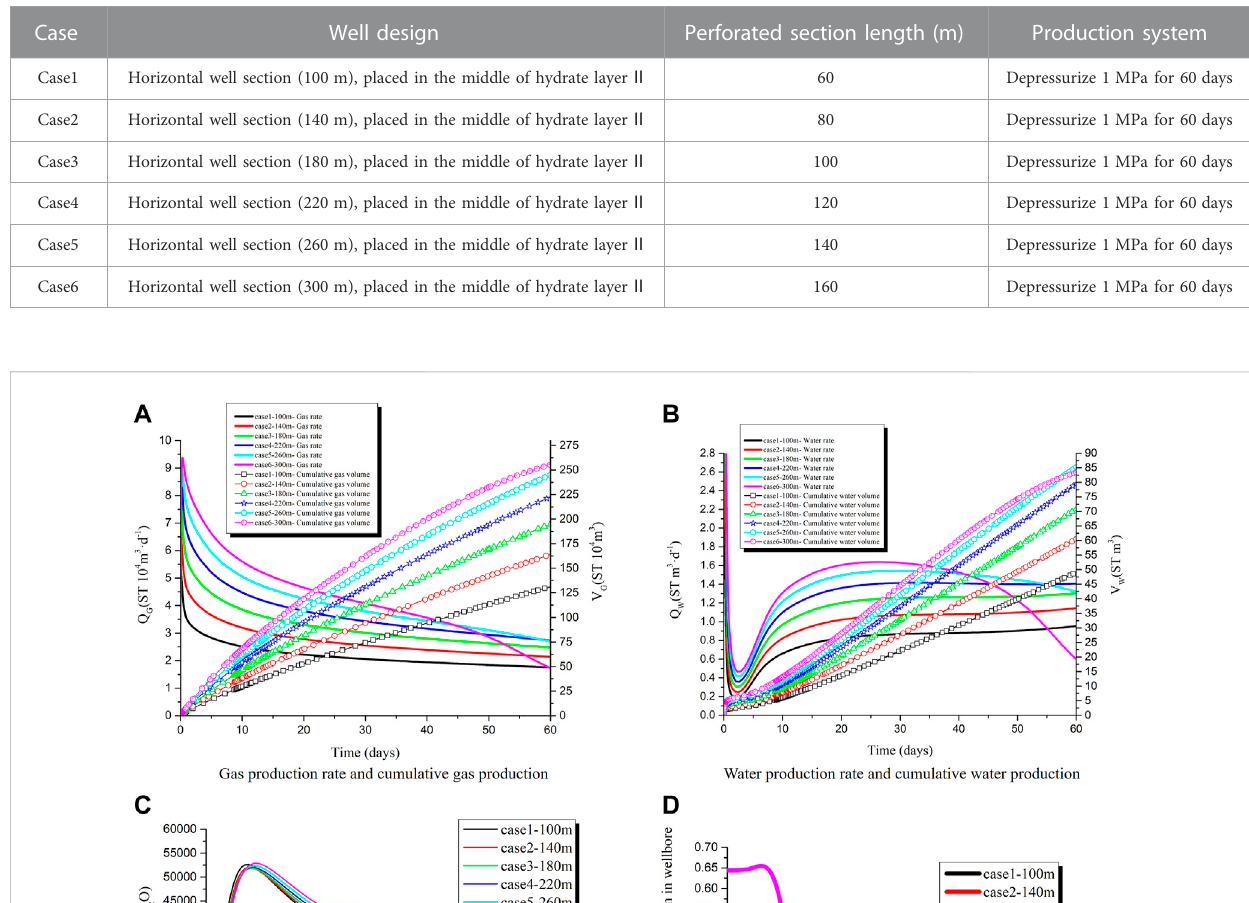
Figure 7D. With the increase of the length of the horizontal well